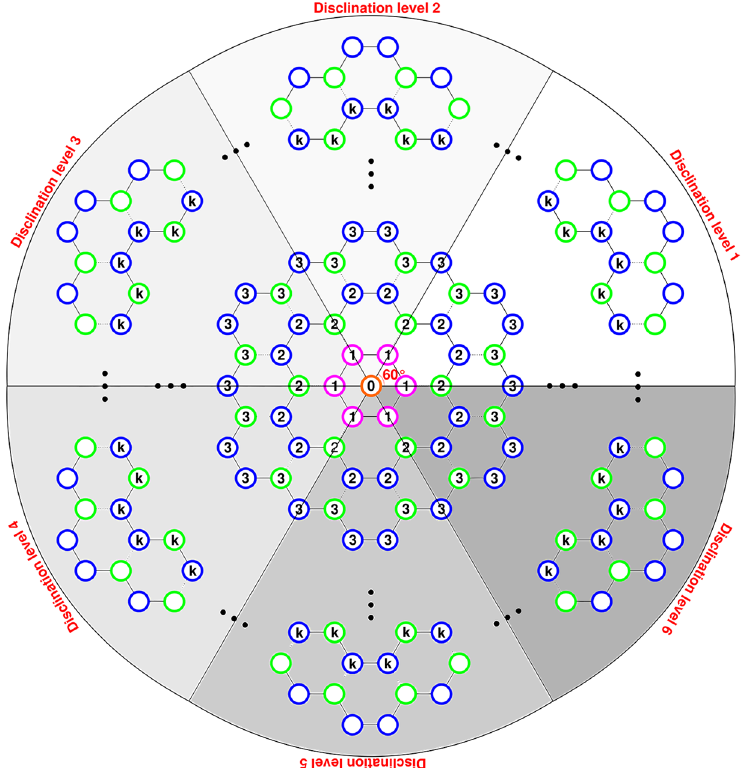
Figure 5. Indexing of circular loops of sideways connected atoms that are part of a virtual graphene disk. The green atoms represent dangling bonds, the blue ones represent bonded atoms, and the pink ones are part of the central ring of the CNC. The orange circle marked with 0 is there just for the reference of the center of the circle. The number inside each atom represents its index number.